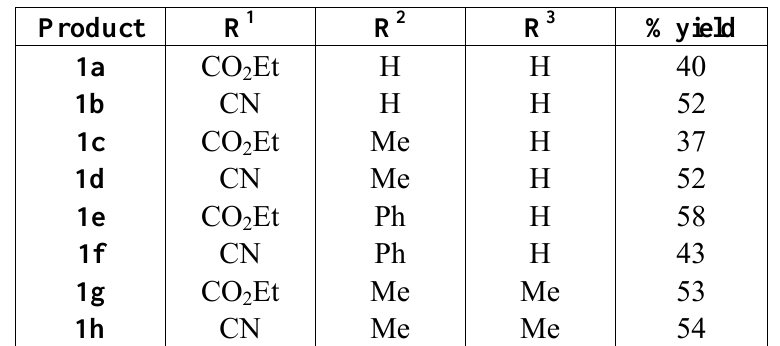
Table 1. Yields of 4-aminofuranones